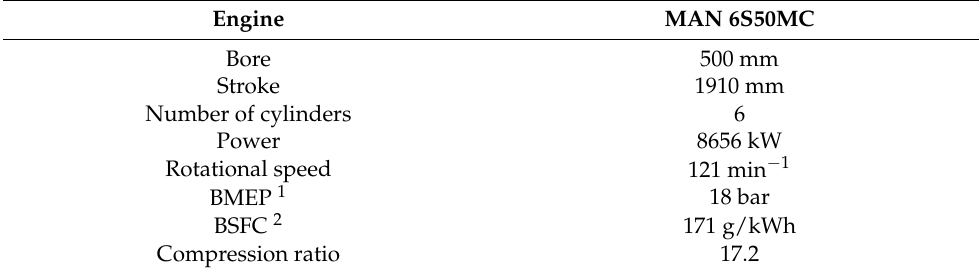
Table 1. Technical data of the engine MAN 6S50MC.